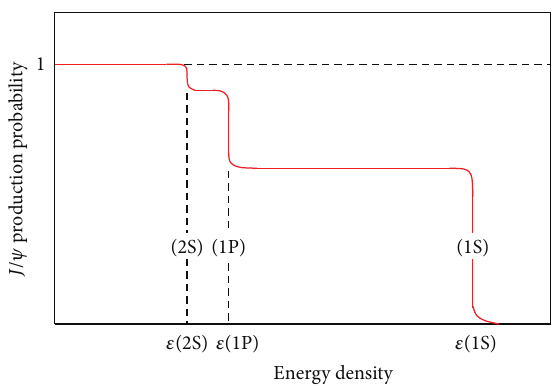
Figure 2: Schematic view of sequential 𝐽/𝜓 suppression in a decon- fined